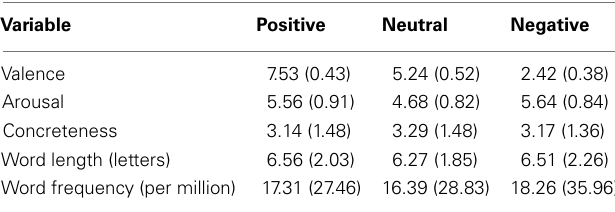
Table 1 | Characteristics of the word stimuli used in the